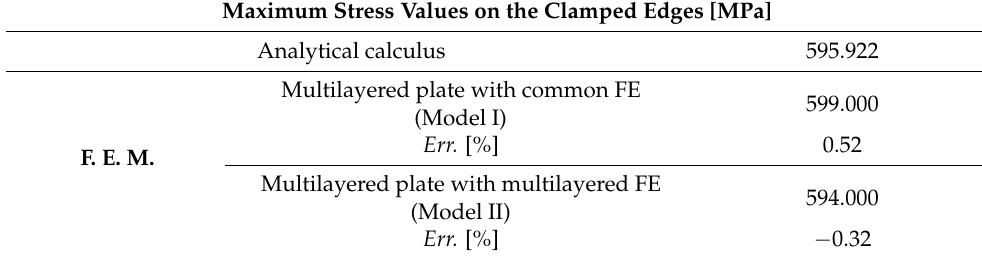
Table 8. The results of the stress